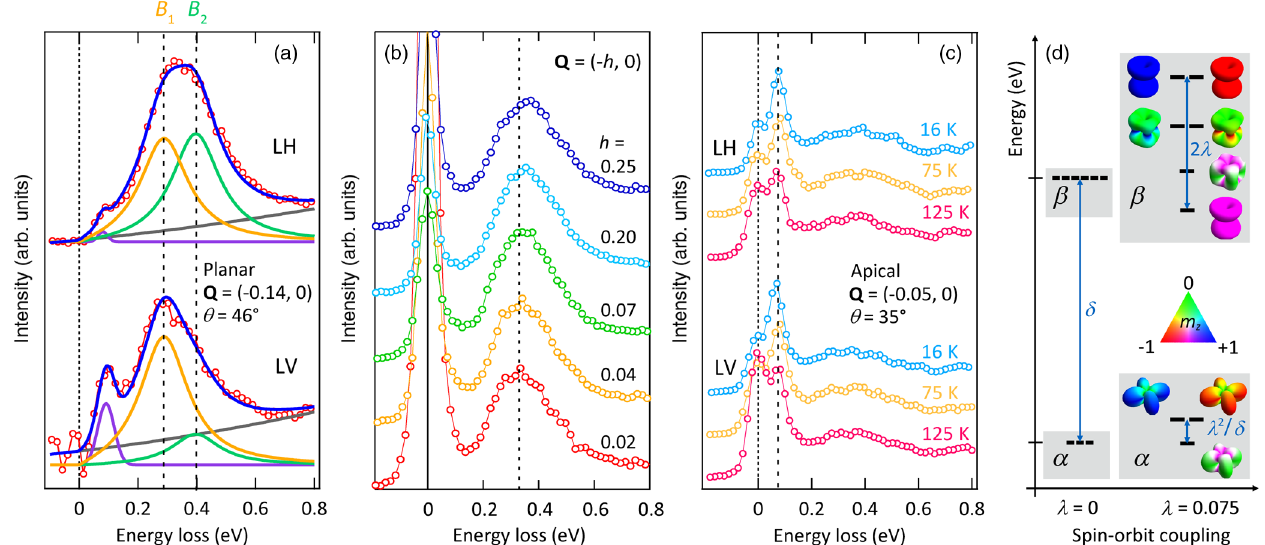
FIG. 4. (a) Same spectra as in Fig. 2 displayed with emphasis on the low-energy excitations. Solid blue lines are a four-component fit, including a smoothly growing background (gray lines — second-order polynomial form), the 80-meVexcitation (purple line — Gaussian line shape), and two modes with damped harmonic oscillator line shape [32 – 34] labeled B 1 (yellow) and B 2 (green) for the excitation at 400 meV. The position and width of B 1 and B 2 are assumed to be identical for LVand LH polarization. Peak amplitudes, by contrast, are left as open fit parameters irrespectively of light polarization. (b) RIXS spectra at planar resonance recorded using linear horizontal light polarization as a function in-plane momenta, as indicated. (c) Apical RIXS spectra recorded with LV and LH polarization near normal incidence for temperatures, as indicated. Lines in panels (b) and (c) are guides to the eye. (d) Schematics of low-lying energy levels of an interacting model for a single ruthenium site for spin-orbit coupling λ set to zero (left) and to the physical value in Ca 2 RuO 4 (right). With four electrons, one of the orbitals d , d , d is doubly occupied, and the two singly occupied electrons are in a spin-triplet state. Finite xy xz yz spin-orbit coupling lifts the degeneracies of the two sectors denoted α and β . The character of the doubly occupied orbital is displayed along with a color scale indicating the directional dependence of the total spin m z